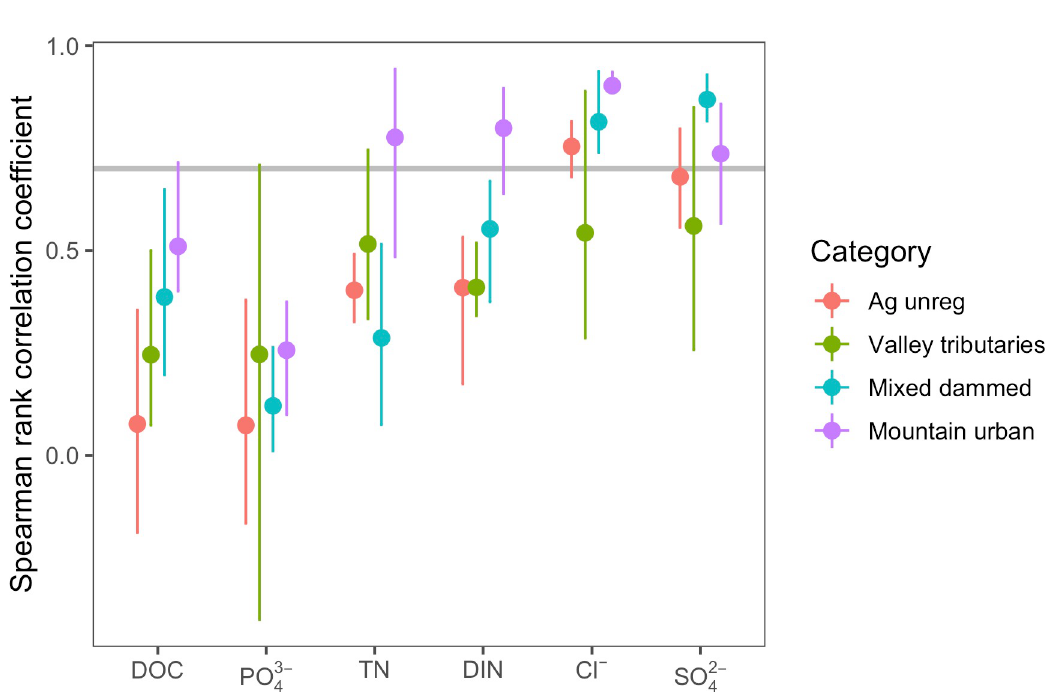
Fig 6. Spatial persistence for solutes (DOC, PO43-, TDN, DIN, Cl - , and SO42-) for different categories of land use within the Utah Lake watershed. Spatial persistence is calculated as a pairwise Spearman rank correlation coefficient ( ρ) among synoptic samplings from three seasons (Spring, Summer, and Fall). Points represent mean ρ for all pairwise comparisons within each category, and bars give the range of values. The horizontal grey line marks ρ = 0.7; indicating that the majority of the spatial pattern was retained between the two